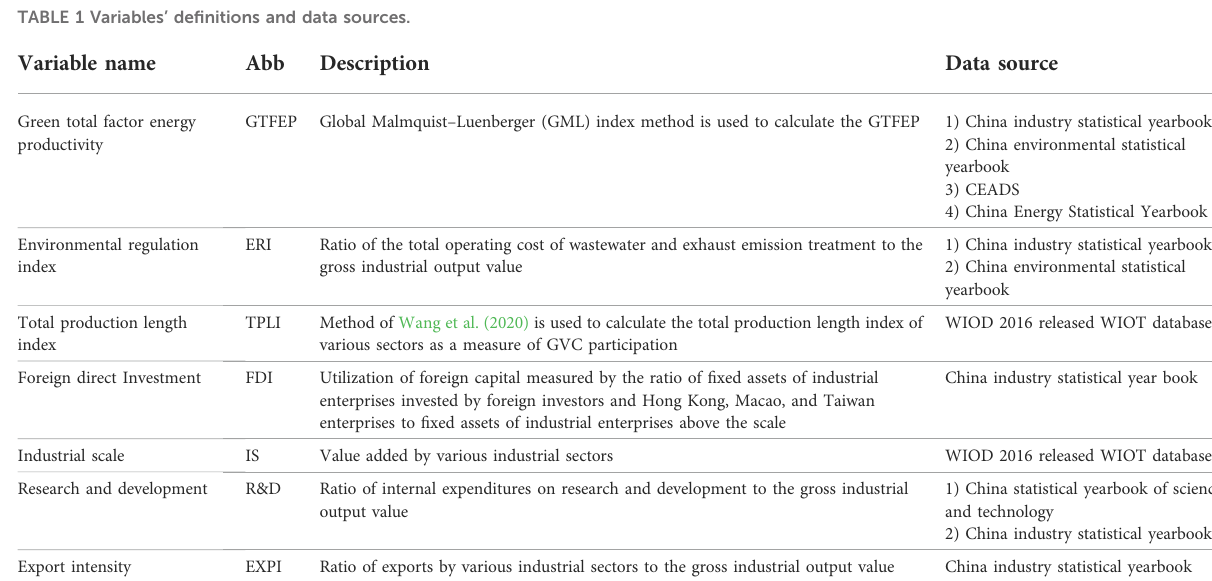
TABLE 1 Variables ’ de fi nitions and data